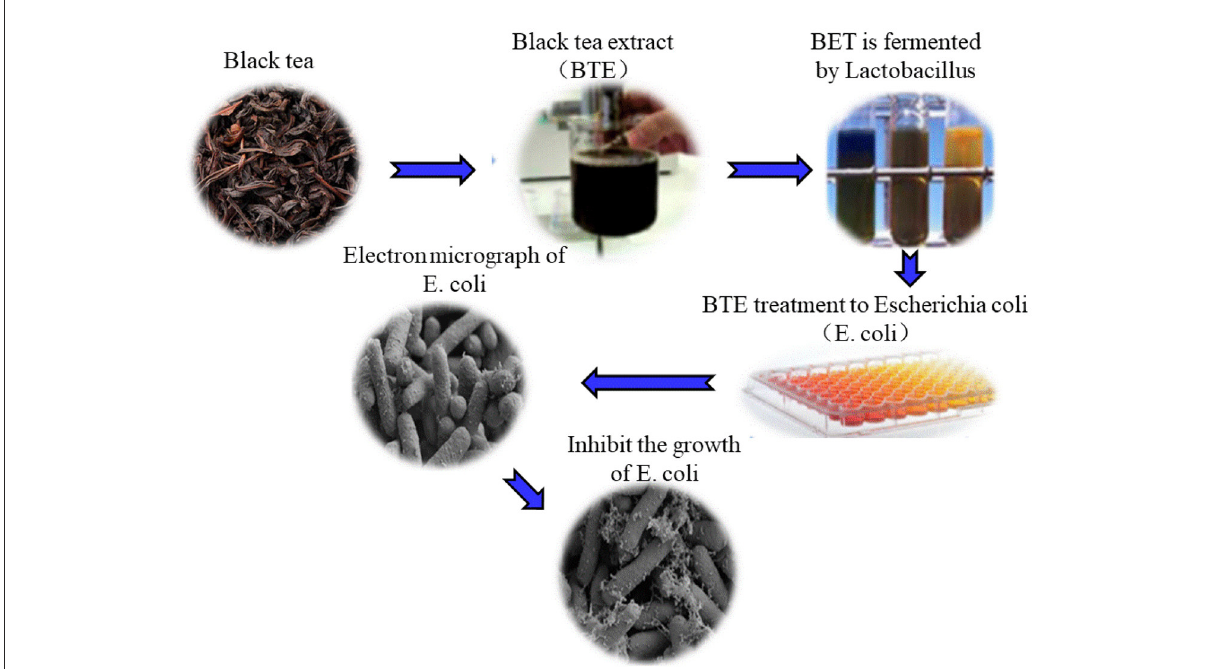
FIGURE3 The inhibitory effect of fermented black tea extract on Escherichia coli . The cell membrane and cell division of Escherichia coli were damaged by 25 mg/ml fermented tea